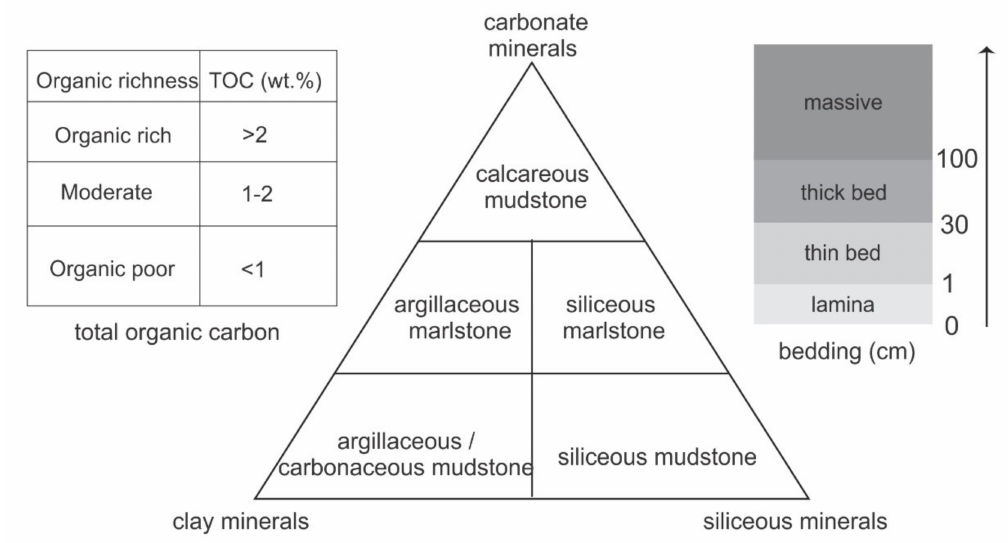
Figure 2. Classification scheme for shale lithofacies based on TOC [10], mineralogy, and bed